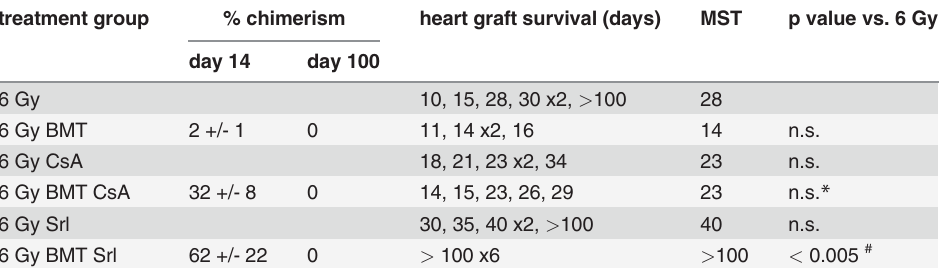
Setting of experiments and strain combinations are based on the Table 3. Groups are named according the pre-treatment by TBI, BMT and application of immunosuppression for 14 days starting at BMT. The degree of chimerism in blood of heart graft recipients is given for day 14 and day 100. Survival of each single heart graft transplanted at day 16 and mean survival times (MST) are given. The statistical signi fi cance was appointed at p < 0.05. P values of each group are compared to the 6 Gy TBI control group (n.s. = not signi fi cant). Additional statistical tests showed that * the immunosuppressive coverage by CsA did not prolong heart graft acceptance with BMT (6 Gy BMT CsA vs. 6 Gy BMT; p = 0.06) nor without BMT (6 Gy CsA vs. 6 Gy; p = 0.42). # Immunosuppressive coverage by Srl signi fi cantly prolonged heart graft